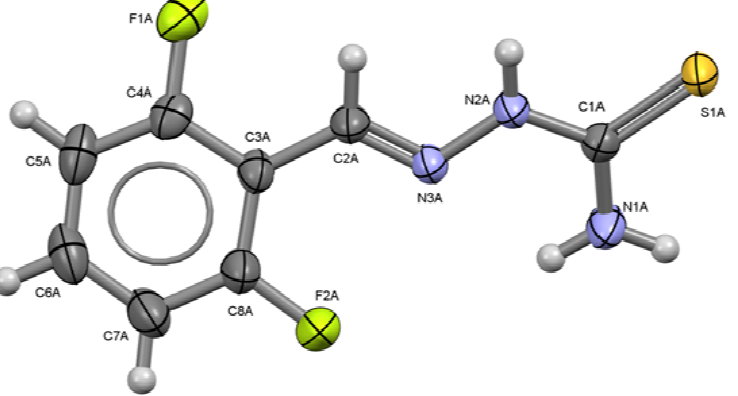
Figure 3. ORTEP drawing of 2,6-C ellipsoids are shown at 50% of probability. Selected bond lengths (Å) and angles (°): S1A-C1A 1.6926(18), C1A-N1A 1.320(2), C1A-N2A 1.339(2) N2A-N3A 1.378(2), N3A-C2A